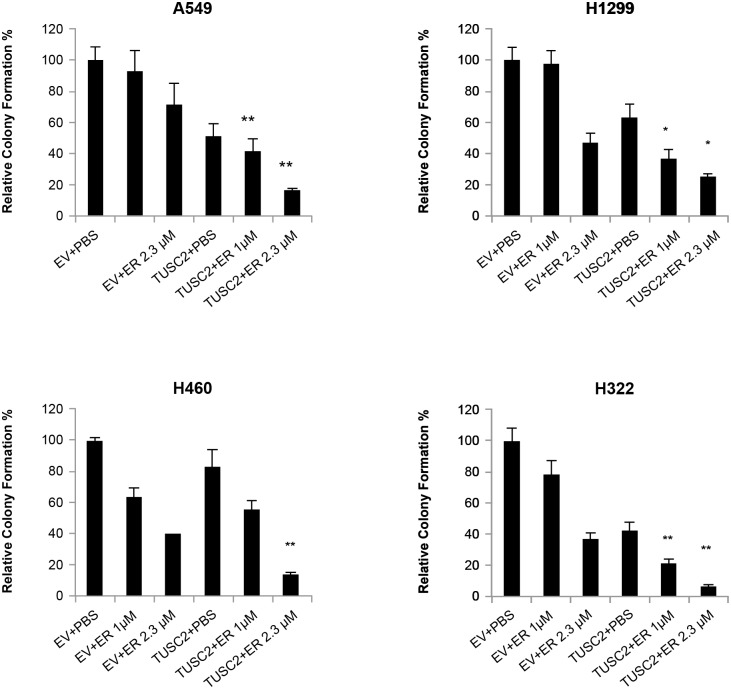
Combination of TUSC2 transient expression and erlotinib treatment inhibits colony formation significantly.TUSC2-deficient wild type EGFR NSCLC A549, H1299, H460, and H322, were transfected with four micrograms TUSC2 pcDNA3. After G418 selection, cells were treated with 1.0μM or 2.3μM erlotinib, colonies were fixed with glutaraldehyde, stained with crystal violet, and counted using a stereomicroscope. Data shown is expressed as the mean ± SE. Values represent the mean of three independent experiments. The statistical significance of differences was calculated by two-tailed t test analysis; *, P< 0.05, **, P<0.01. The cooperative effect of the TUSC2 transfection and erlotinib combination was >0.99 for each cell line.